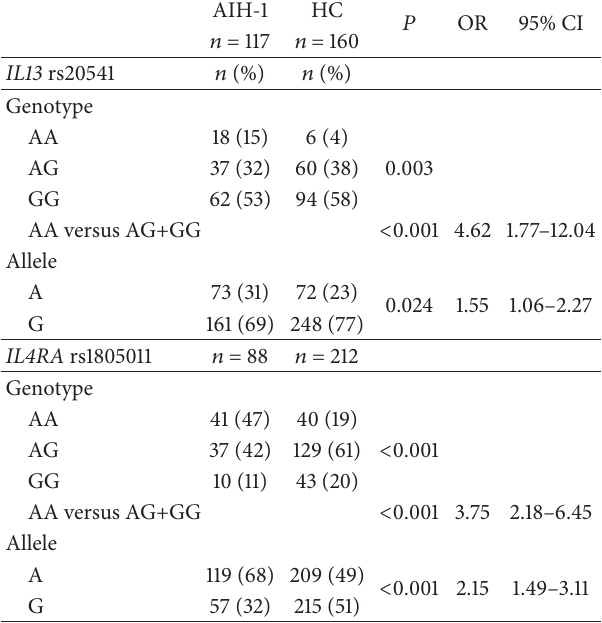
Table 4: Genotype and allele frequencies of IL13 rs20541 and